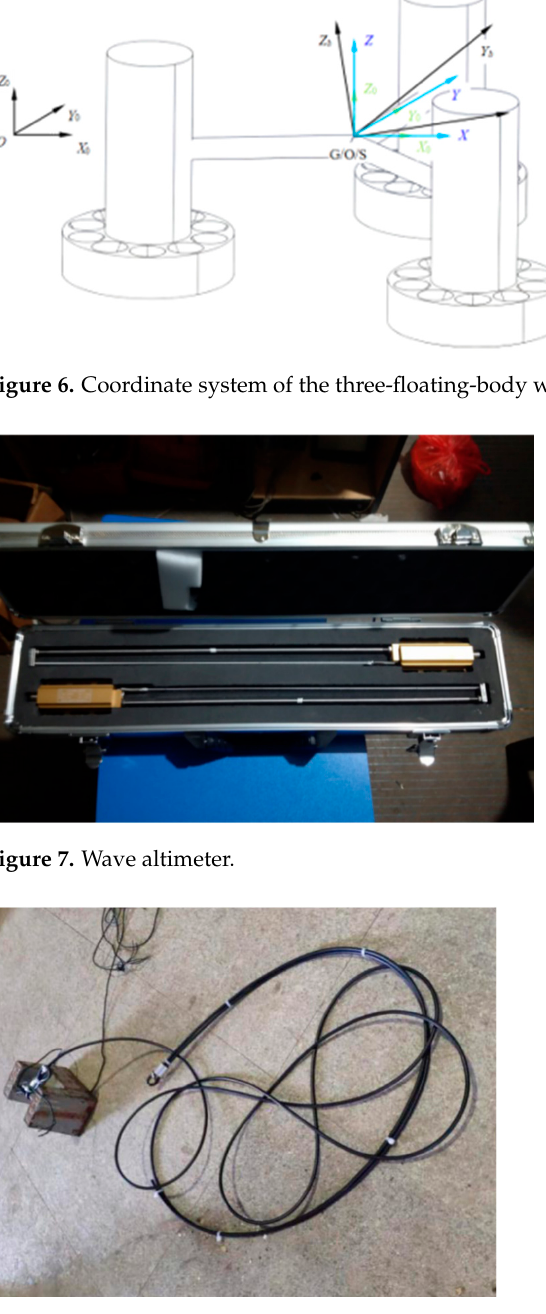
Figure 6. Coordinate system of the three-floating-body wind turbine platform.